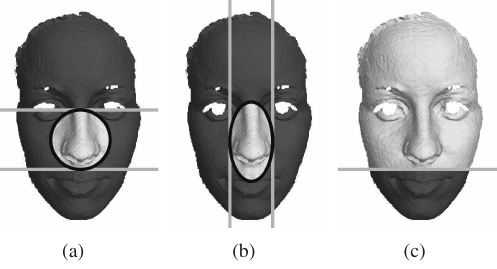
Fig. 7. Rigid regions extraction guided by the facial landmarks